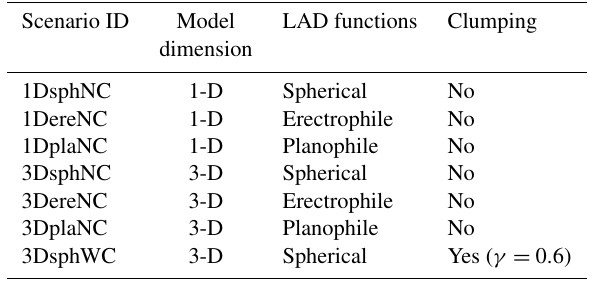
Table 1. Simulation scenarios for the 1-D and 3-D comparisons with an actual diurnal incident PAR data. Scenario ID